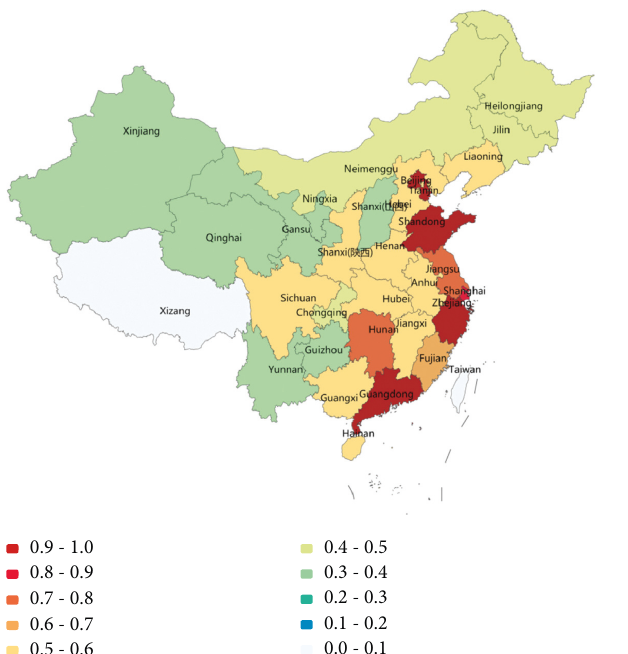
Figure 8: 2019 EEE value in